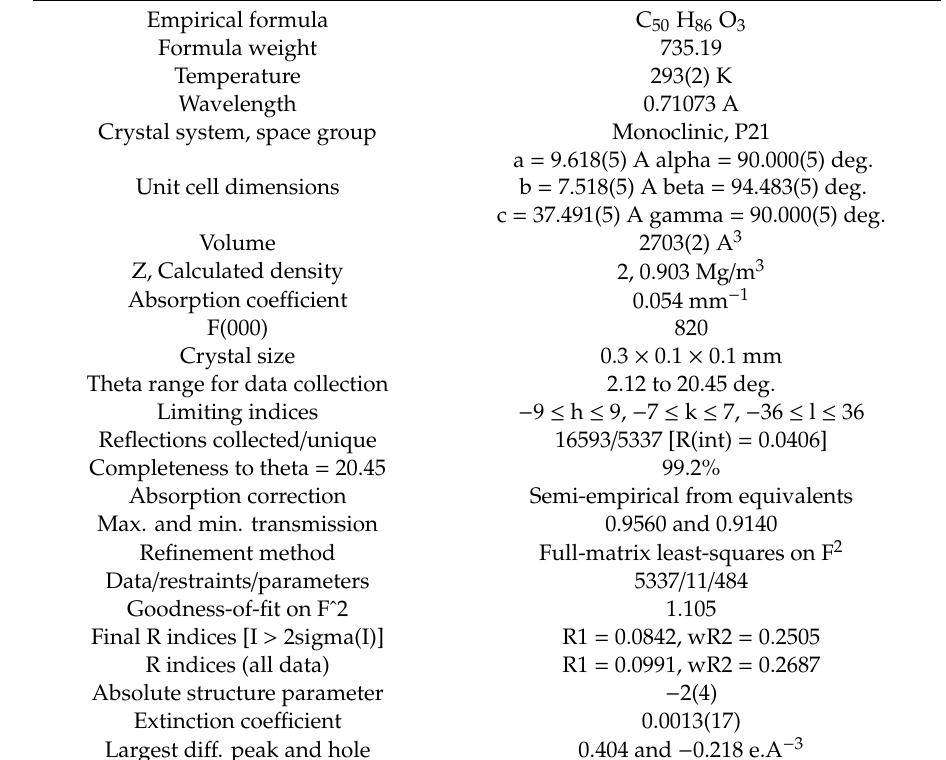
Table 1. Crystal data and structure refinement for the novel compound, nymphayol, isolated from the chloroform extract of Nymphaea stellata